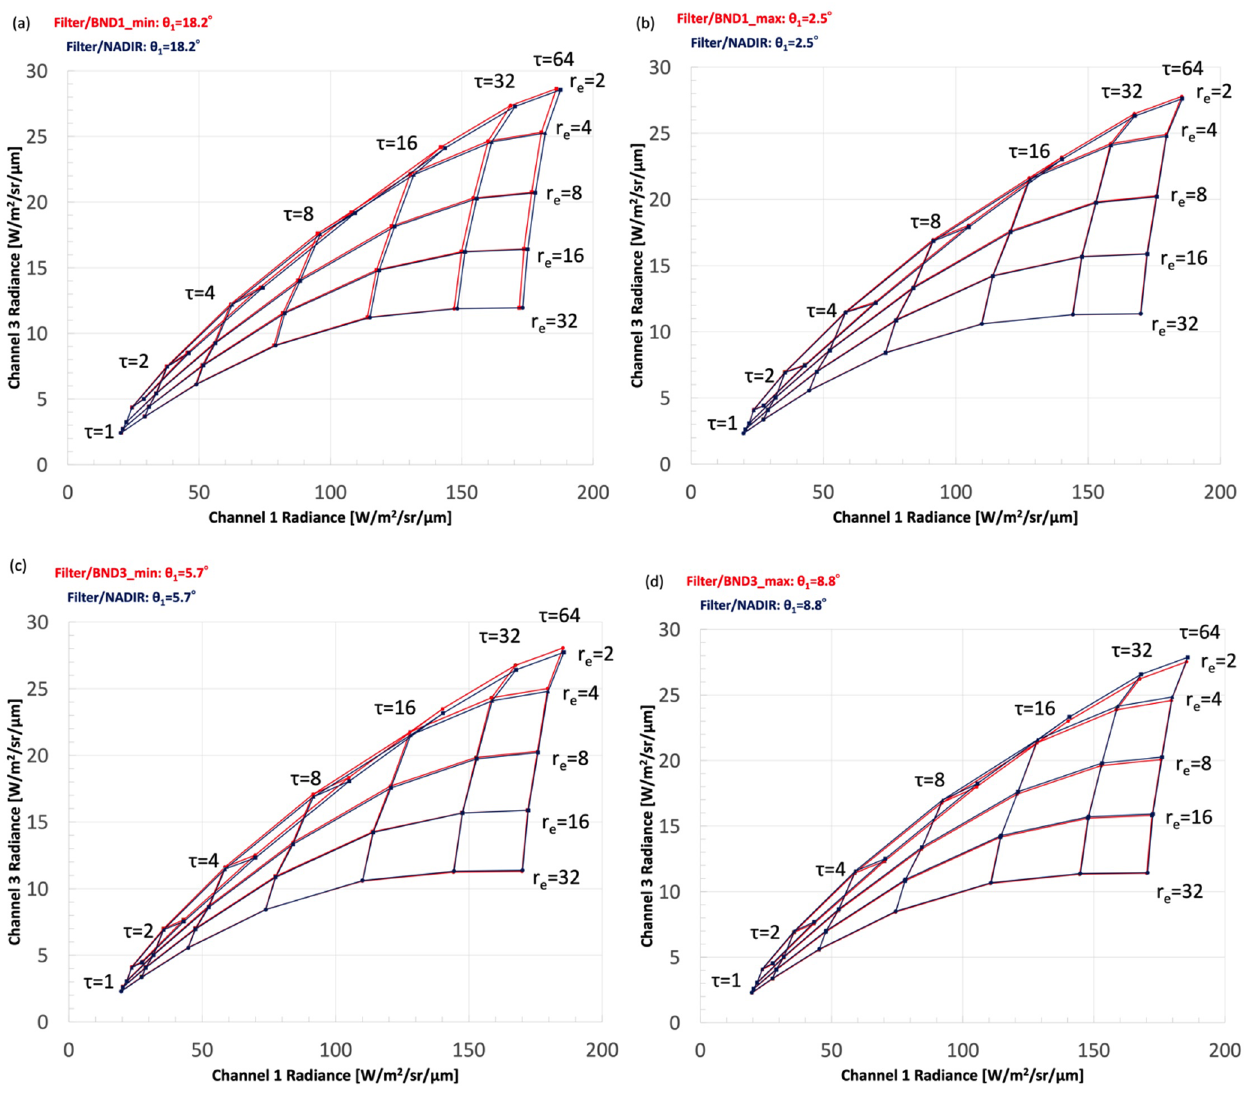
Figure 3. Nakajima–King diagrams for shallow warm clouds at (a) pix_BND1_min, (b) pix_BND1_max, (c) pix_BND3_min, and (d) pix_BND3_max for a solar zenith angle of 60 ◦ . The red lines show the results from the response function with SMILE. The black lines show the results from the nadir response